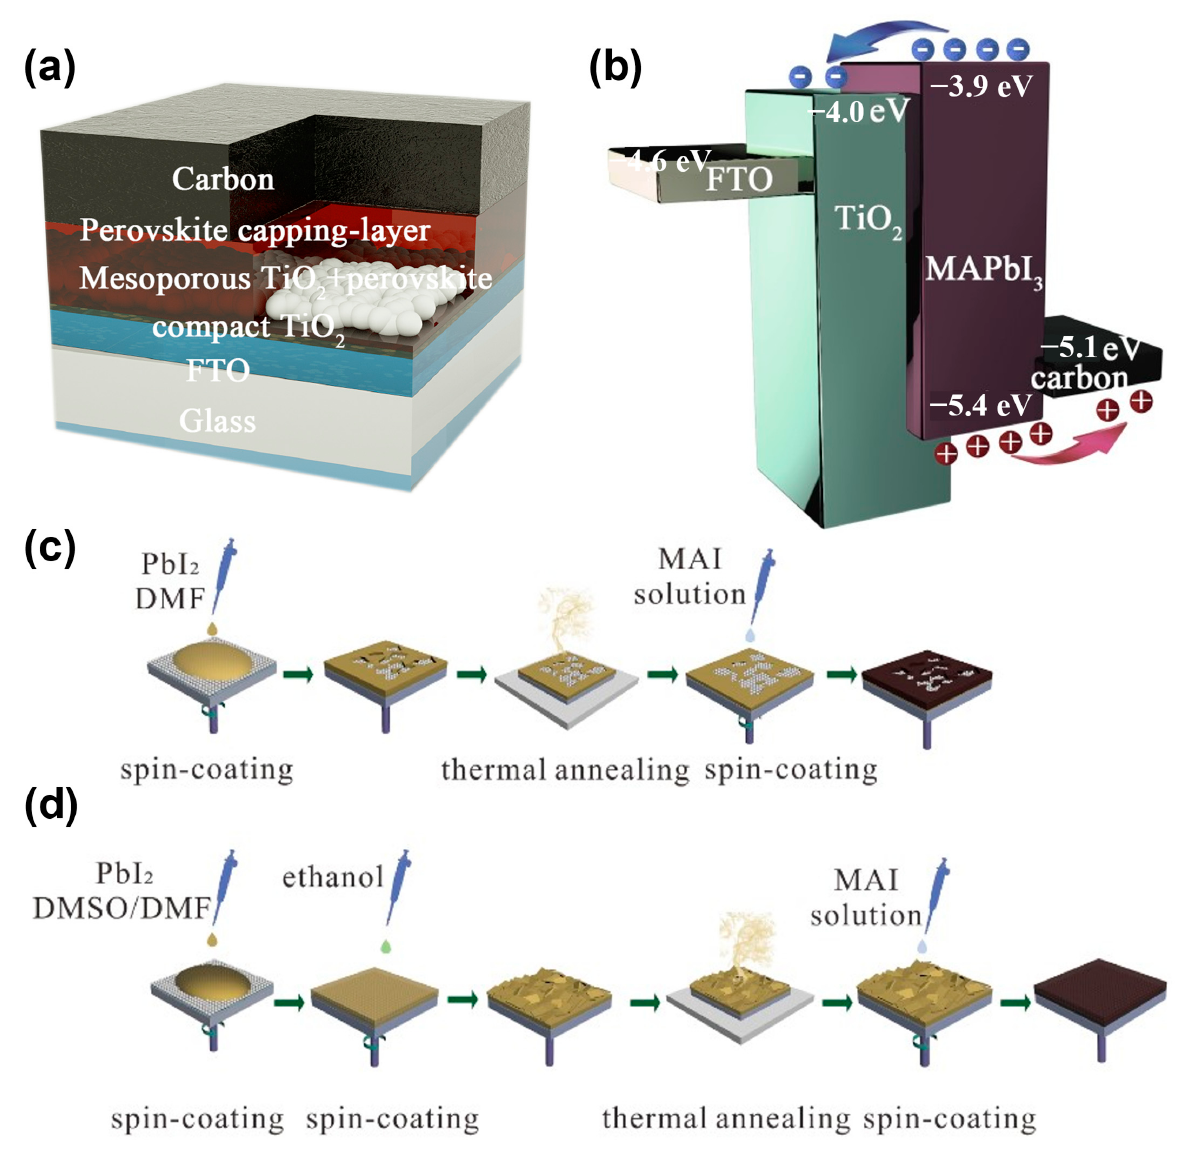
Figure 1. Schematic demonstrating the ( a ) device architecture, ( b ) energy level alignment, ( c ) manufacture process of perovskite thin films by primal and ( d ) modified sequential deposition methods.